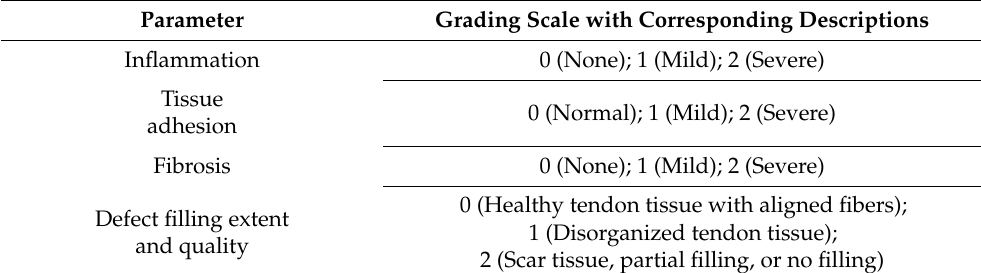
Table A2. Scoring table for macroscopic evaluation of the operated rabbit patellar tendons 6 weeks after intervention and treatment.